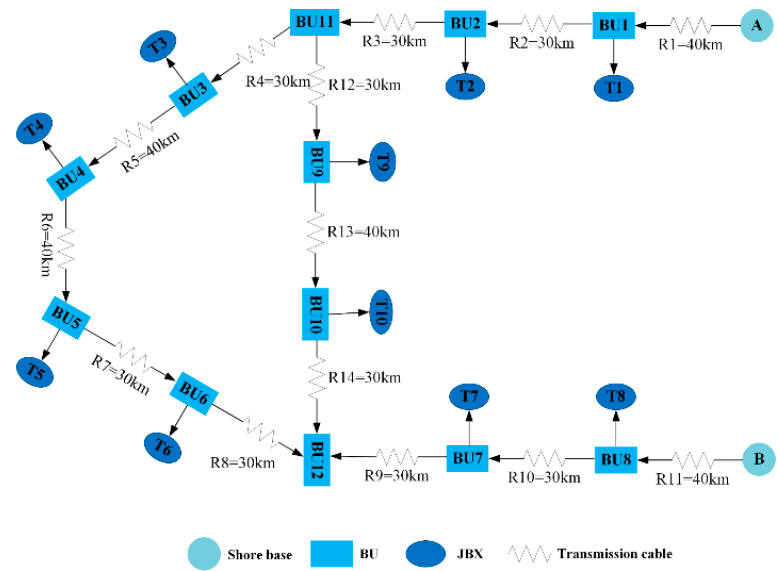
Figure 5. Schematic of an observation network with dual shore station mesh topology.